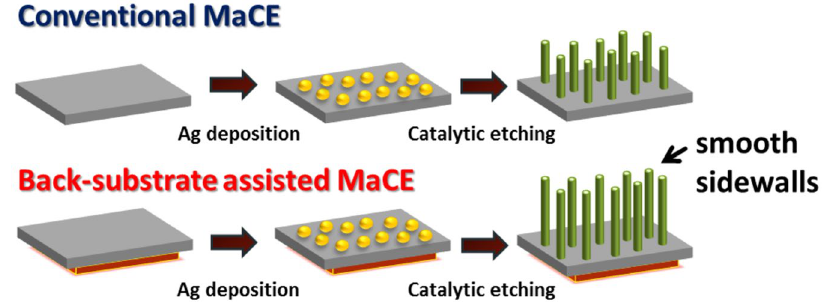
Figure 1. Schematic illustrations for the fabrication procedures of both conventional MaCE and back-substrate assisted MaCE. Notice that the formed nanowires using the modified MaCE method possessed the smooth